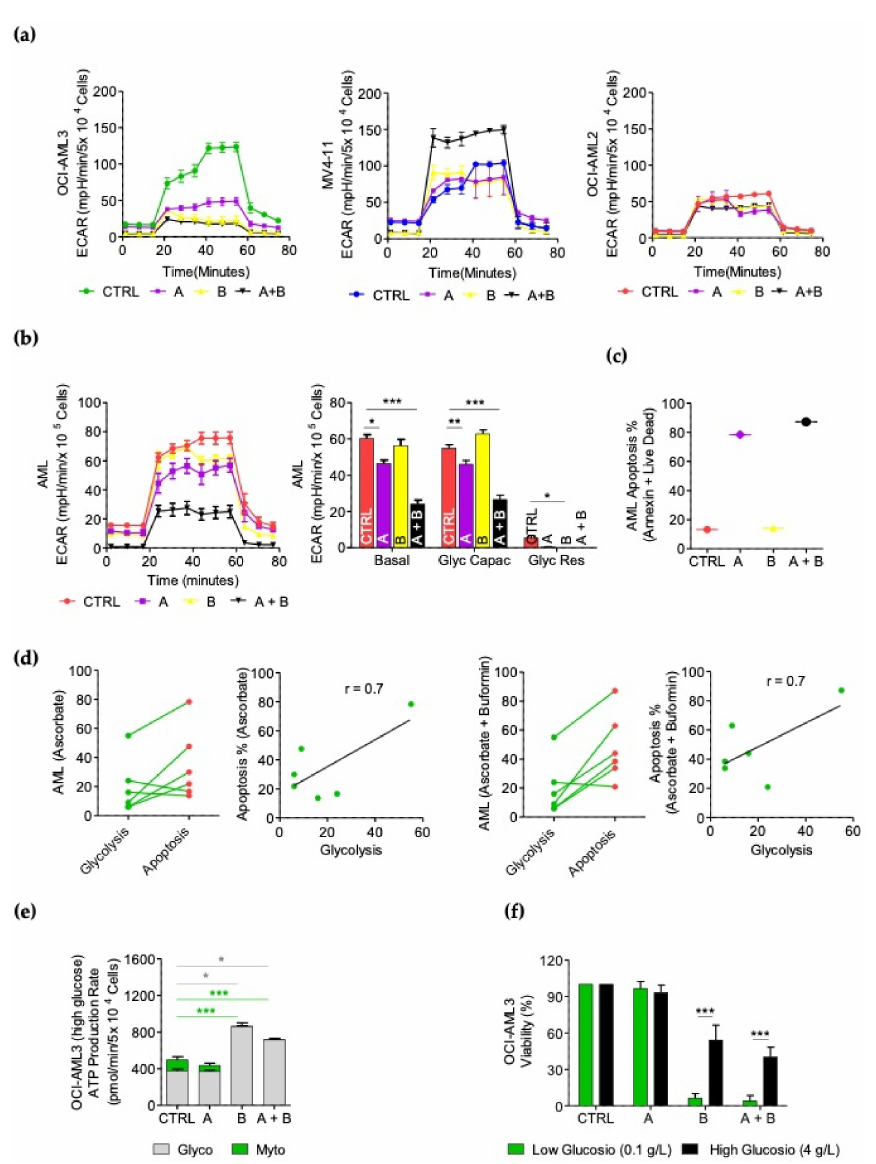
Figure 5. Glycolytic status after buformin plus ascorbate treatment in AMLs. Kinetic profile of ECAR assay in AML cells treated for 24 h with 1 mM of ascorbate (A), 0.1 mM of buformin (B) or ascorbate–buformin combination (A + B) evaluated by XF Glycolytic Stress Test. ( a ) OCI-AML3, MV4-11 and OCI-AML2. ( b ) Primary AML blasts from BM. Histograms represent basal glycolysis, glycolytic capacity (Glyc Capac) and glycolytic reserve (Glyc Res). ( c ) Cell death induced by 1 mM of ascorbate (A), 0.1 mM of buformin (B) or ascorbate–buformin combination (A + B) at 72 h in primary AML blast from the same AML patient by flow cytometry after annexin V + live dead staining. ( d ) Linear correlation between apoptosis and glycolytic levels in AML samples treated with both ascorbate or ascorbate–buformin. ( e ) XF real-time glycolytic and mitochondrial ATP production rate by the ATP Rate Assay in presence of high concentration of glucose (4 g/L) after 12 h of 1 mM of ascorbate (A), 0.1 mM of buformin (B) or ascorbate–buformin combination (A + B) in OCI-AML3 cell line. The experiments were performed in duplicate. ( f ) Cytotoxic efficacy of 1 mM of ascorbate (A), 0.1 mM of buformin (B) or ascorbate–buformin combination (A + B) using the CellTiter-Glo ® Luminescent Cell Viability Assay. The cells were cultured at low (0.1 g/L) or high (4 g/L) concentrations of glucose. Three independent experiments were performed in triplicate. Data are presented as mean ± SD. Statistical analysis by Student’s t -test. * p < 0.05; ** p < 0.005; *** p <